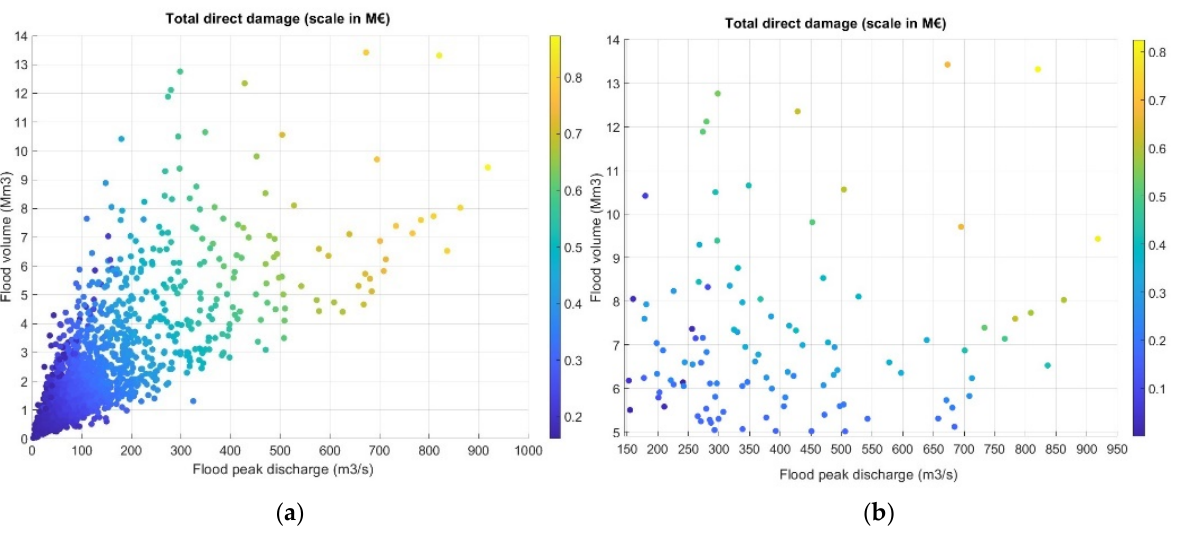
Figure 15. Total direct damage (in MEuro) for different IWL conditions: ( a ) 293.65 m a.s.l. water level (IWL1); ( b ) 290.00 m a.s.l. water level (IWL2).